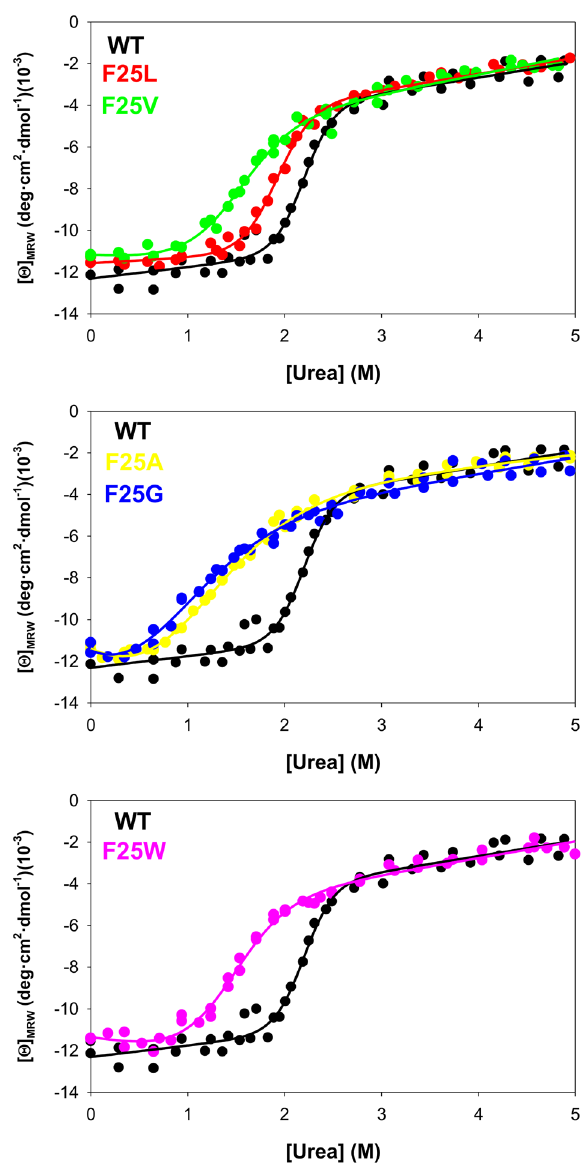
Figure 5. Urea-induced denaturation of hPGK1 variants at 25 °C. 5 µM of hPGK1 variants were incubated for at least 2 h in the presence of increasing urea concentrations in HEPES–NaOH 20 mM NaCl 200 mM 1 mM β-ME, pH 7.4. Then the far-UV CD spectra were acquired and appropriate blanks subtracted. Data are from two independent experiments, and in each experiment the sample without urea was triplicated and averaged. Lines are best-fits to an apparent two-state equilibrium denaturation model (Eq. 6).